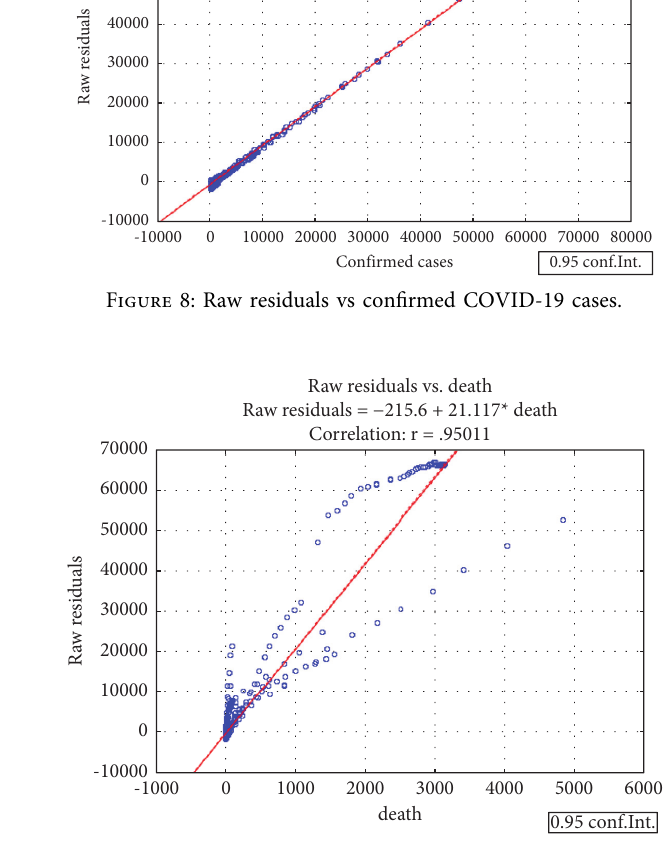
Figure 9: Raw residuals vs COVID-19 deaths. Table 4: Summary of active ANNs.